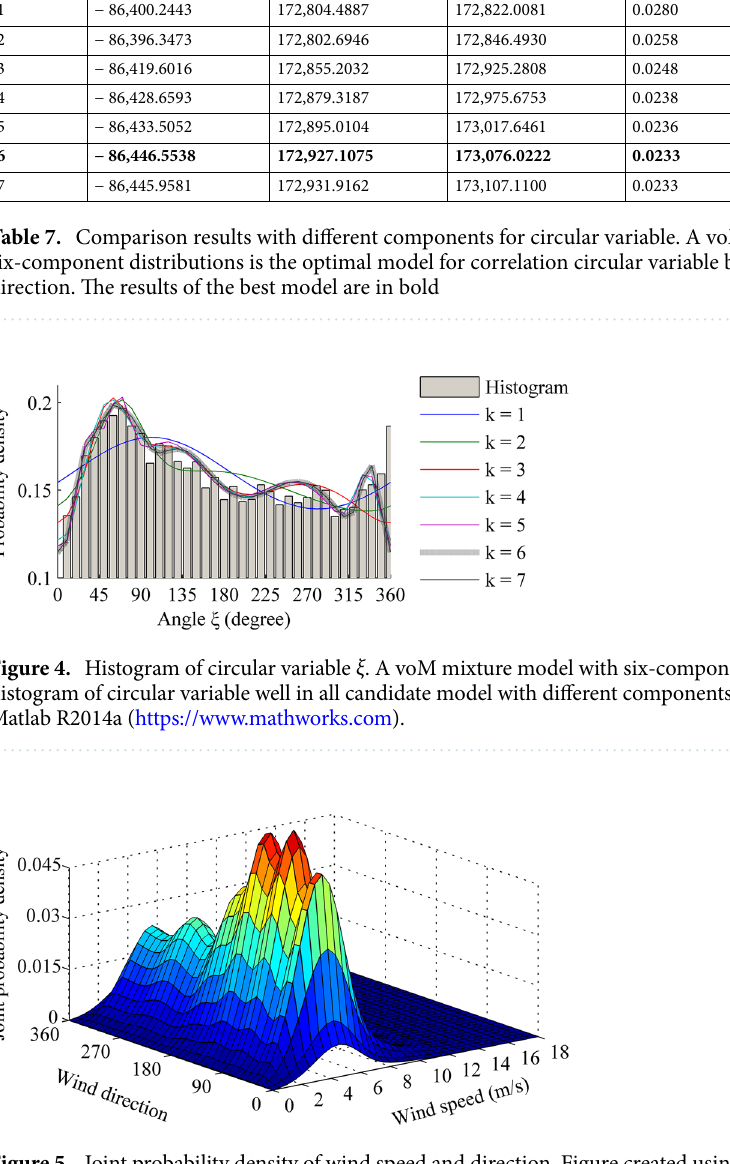
Figure 5. Joint probability density of wind speed and direction. Figure created using Matlab R2014a (https:// www. mathw orks.